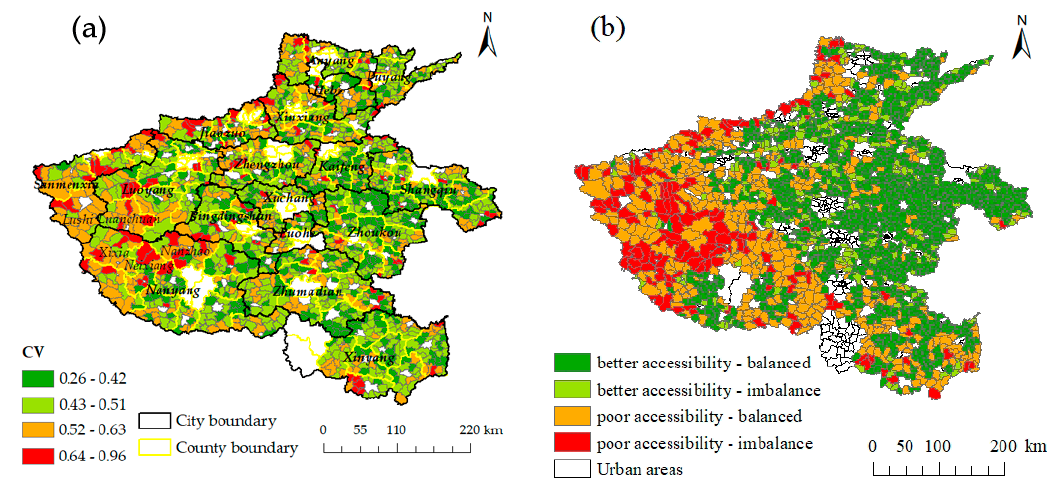
Figure 5. ( a ) Spatial pattern of the CV and ( b ) accessibility ‐ equilibrium.